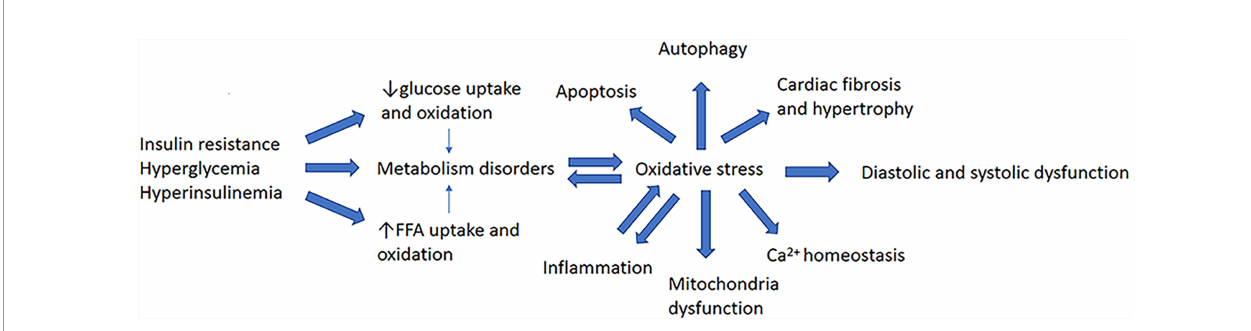
FIGURE 1 | Major pathogenetic features of diabetic